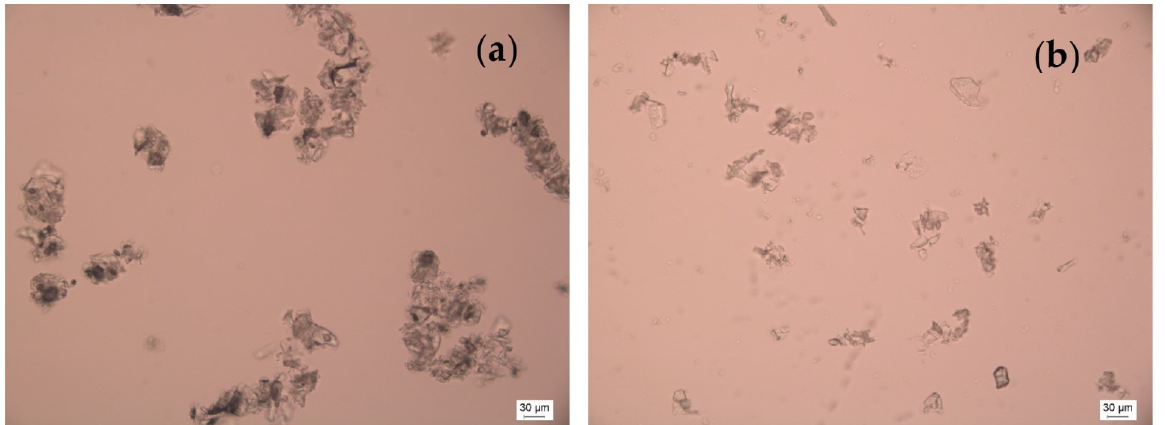
Figure 13. Micrographs of the calcite suspension in the presence and absence of SAF at pH 9. ( a ) scheelite + 100 mg/L NaOL, ( b ) scheelite + 200 mg/L SAF + 100 mg/L